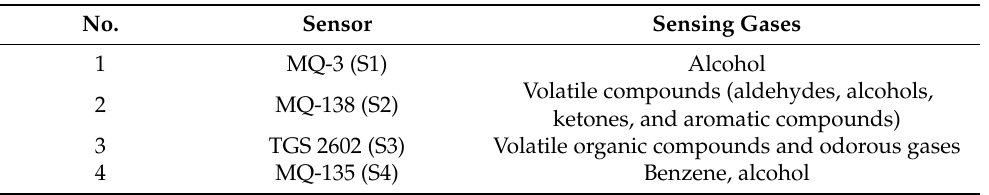
Table 1. Gases detected by each sensor employed in E-nose system.